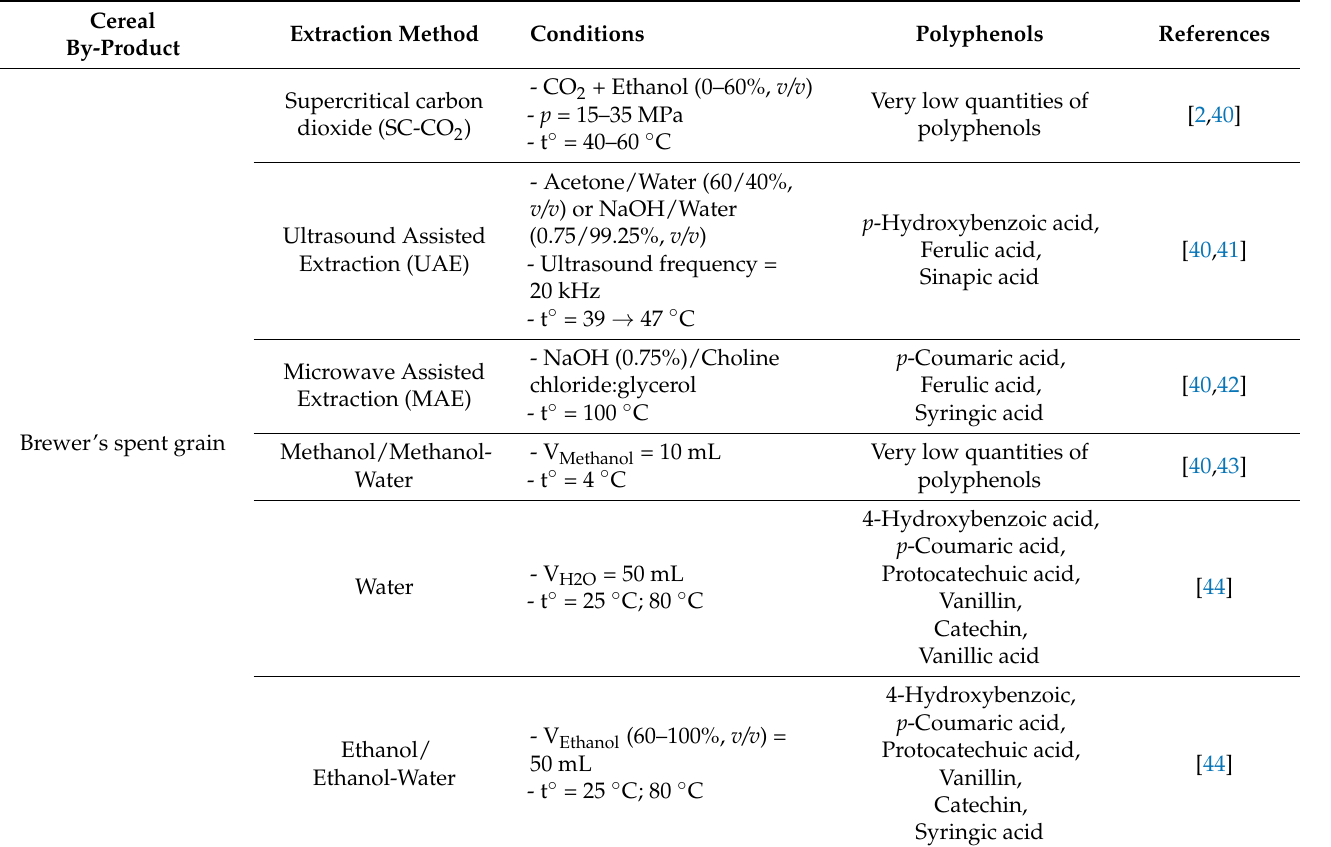
Table 1. The main extraction methods of grains’